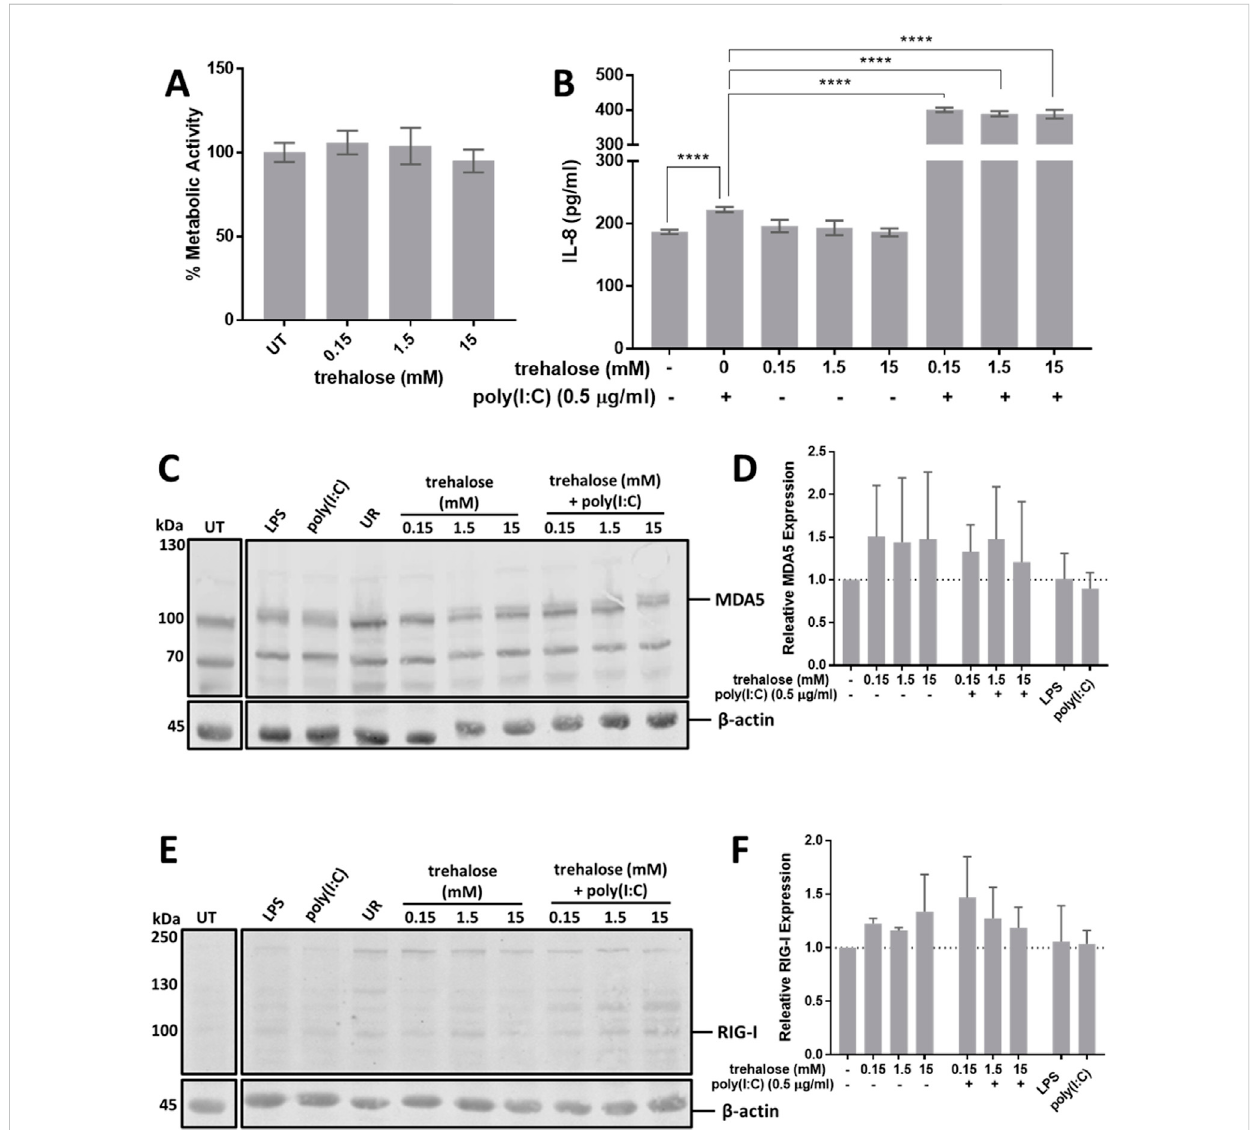
FIGURE 10 Trehalose potentiates poly(I:C) mediated activation of HMC3. (A) HMC3 were treated with 0.15 – 15 mM of trehalose for 24 h and metabolic activity was assessed via XTT assay. (B) HMC3 were left untreated (UT) or treated with 0.15 – 15 mMof trehalose for 3 h and subsequently activated with 0.5 μ g/ mLofpoly(I:C)for24hand (B) cellfreesupernatantsweremeasuredforIL-8 via ELISA.Datapresentedasmean±SEMfor n =3.Statisticalsigni fi cancewas calculatedusingtwo-way ANOVAwithTukeyposthocanalysis: p ≤ 0.0001(****). (C,E) CelllysateswereanalyzedforMDA5andRIGIexpression via Western blot and (D, F) corresponding densitometry analysis was performed. Unrelated samples are annotated as UR. Western blot images are representative of n = 3. Densitometry data presented as mean ± SEM for n = 3 and statistical analysis was calculated using one-way ANOVA with Tukey post hoc